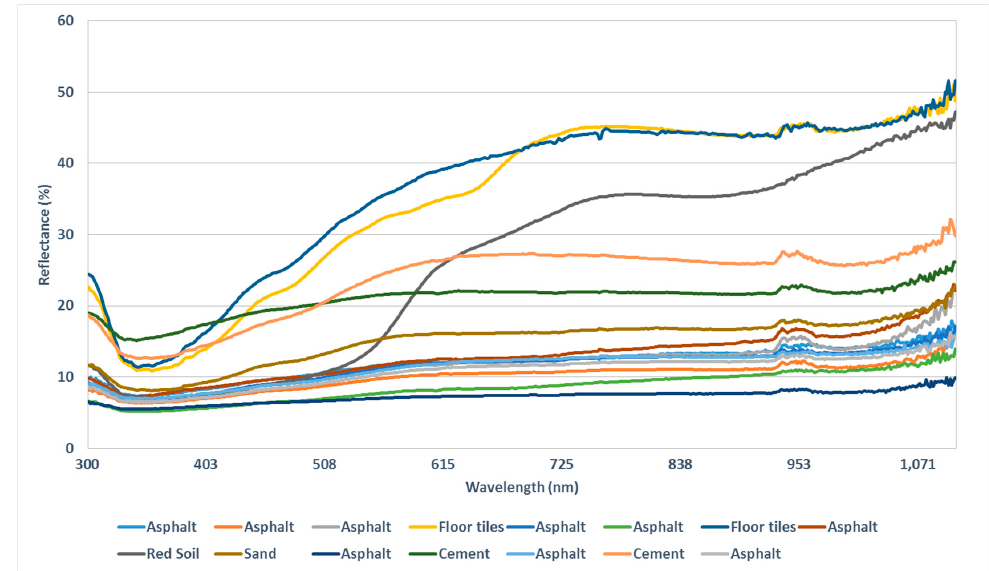
Figure 4. The bidirectional diffuse spectral reflectance measured with the Spectral Evolution PSR-1100 handheld spectroradiometer at 15 sites outside TNP, of which the locations are denoted in Figure 2 and the images of which are provided in Figure 3.